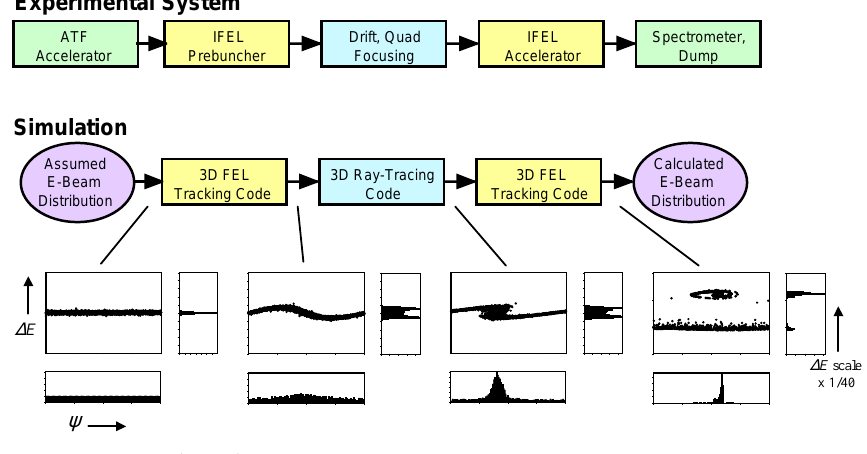
FIG. 11. (Color) Schematic flow chart of the integrated STELLA